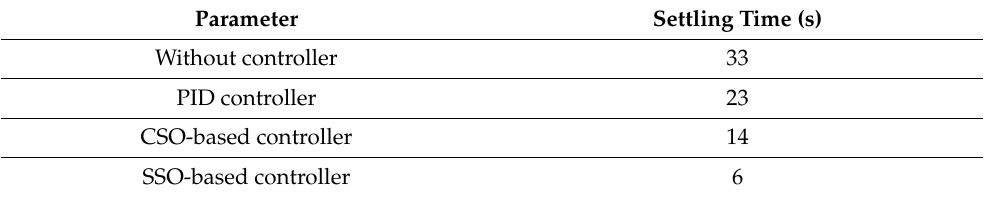
Table 2. Comparison of Settling Time of Speed Response of All The